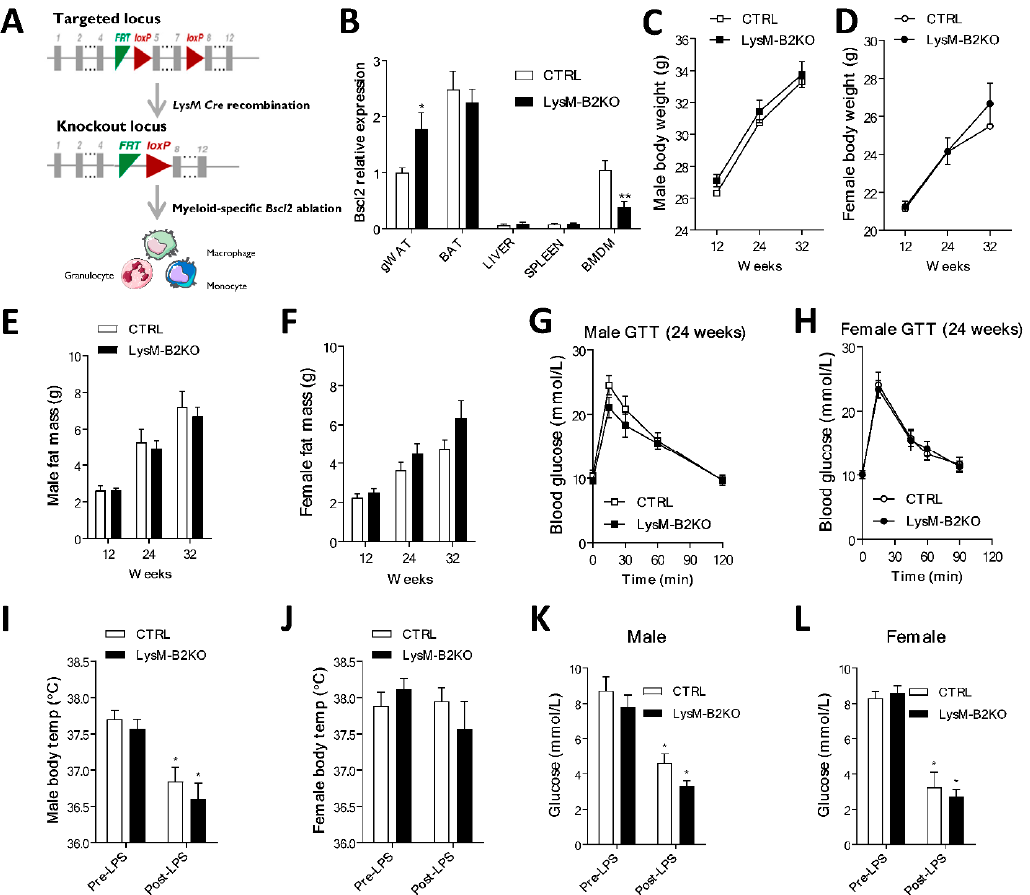
Figure 1. Physiological characteristics and lipopolysaccharide (LPS)-mediated inflammatory response in LysM-B2KO mice. ( A ) Targeting strategy for the conditional disruption of the Bscl2 gene in the myeloid lineage. ( B ) Bscl2 mRNA expression across different tissues and bone-marrow-derived macrophages (BMDM) of LysM-B2KO mice relative to the 18s gene. ( C , D ) Male and female body weight, ( E , F ) male and female fat mass, and ( G , H ) male and female glucose tolerance of LysM-B2KO mice at 24 weeks of age. Effect of LPS on the ( I , J ) body temperature and ( K , L ) serum glucose in male and female LysM-B2KO mice at 32 weeks of age (female n = 5–7, male n = 7–10). Data are represented as mean ± SEM, * p < 0.05, ** p <